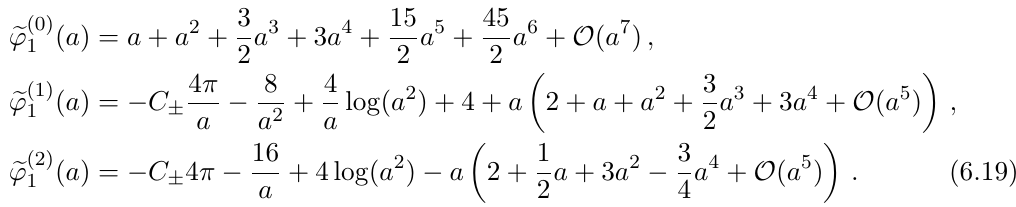
Figure 4 . Free energy coefficients F 0 , 1 rescaled by − 2 π/h 2 as a function of the coupling of the external field h with m set to 1. The orange and black lines correspond to the perturbative and exact results, respectively, for both the leading (left) and next-to-leading (right) orders in ∆ . while for ϕ we 1 e